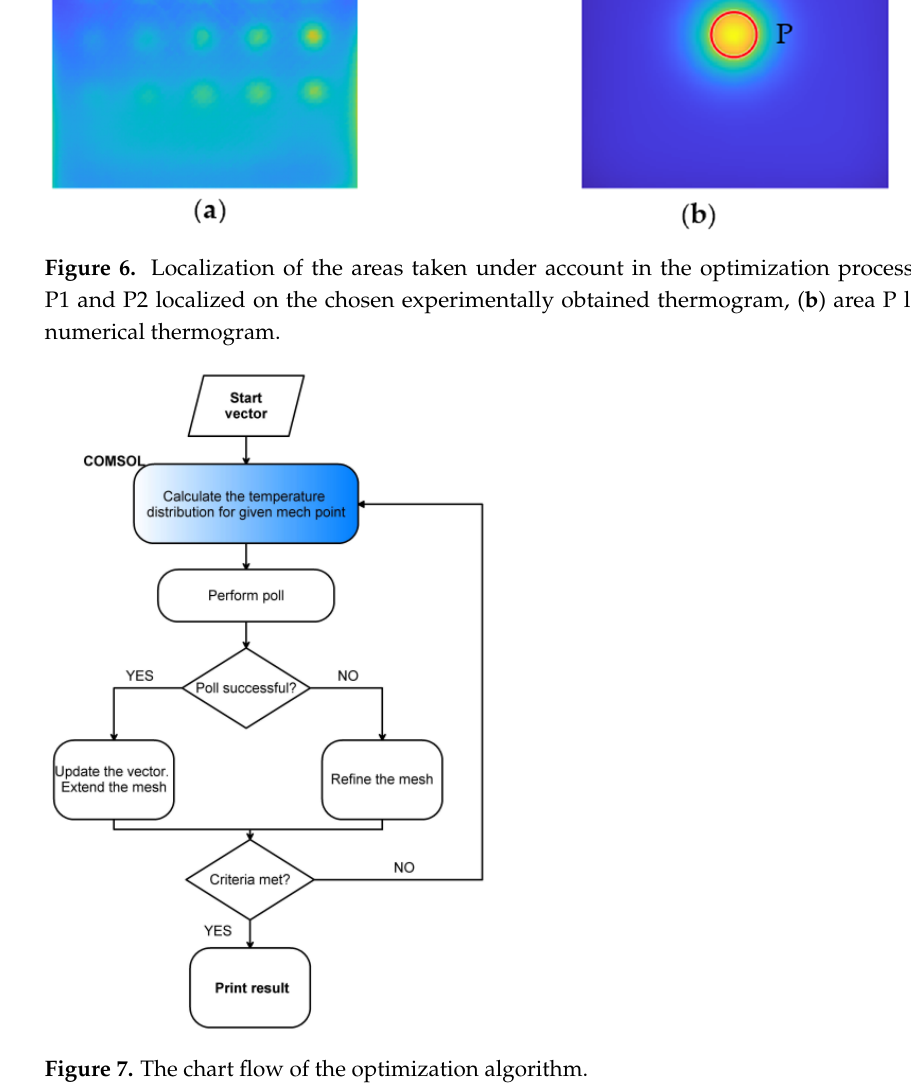
Figure 6. Localization of the areas taken under account in the optimization process. ( a ) Areas P1 and P2 localized on the chosen experimentally obtained thermogram, ( b ) area P localized on numerical thermogram.